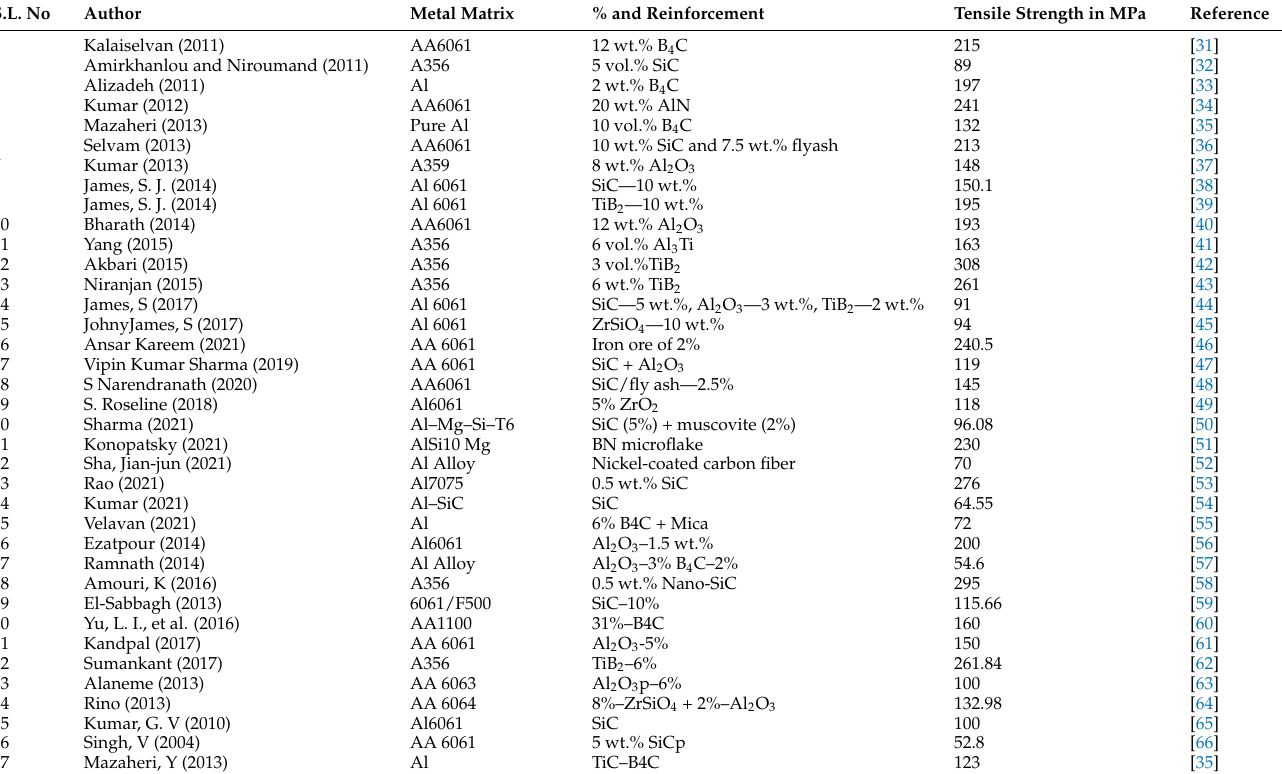
Table 1. Various tensile strength values of developed